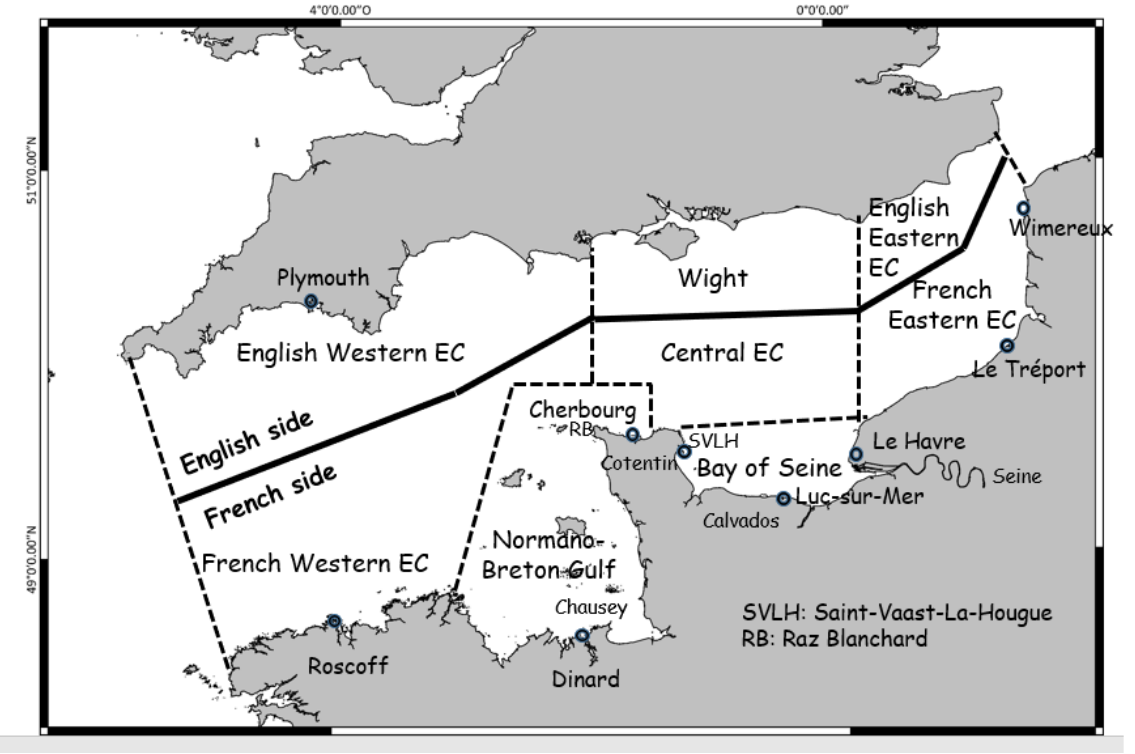
Figure 1. Map of the English Channel with the limits of the eight zones and the locations of the main amphipod sampling zones.